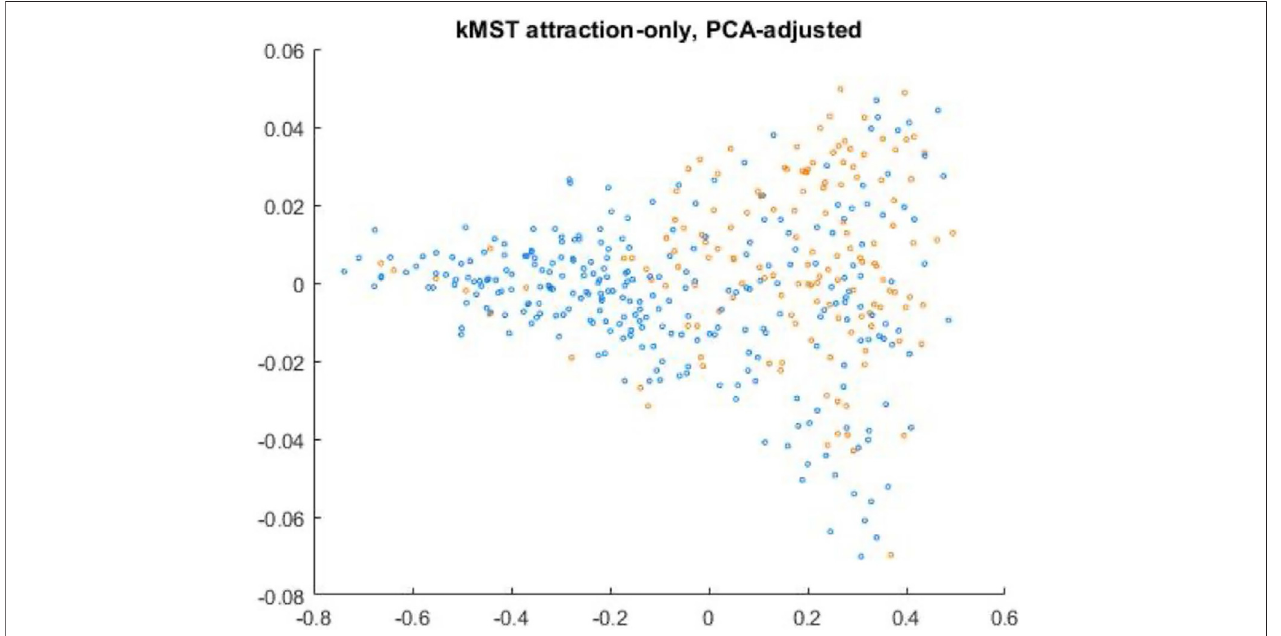
FIGURE 5 | Representative example of 5-MST force-directed result using PCA-reduced data. IDH-mutated patients are shown in orange, while IDH-wildtype is blue. The algorithm was run for 1800 iterations, with the values of kEq and kAtt held constant. The X - and Y -axes represent spatial coordinates for visualization of the minimum spanning